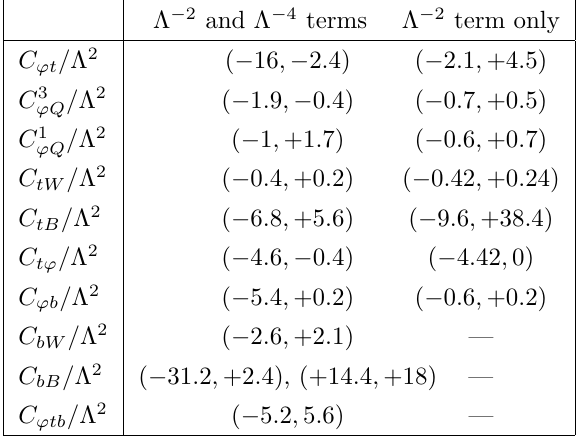
Table 2 . The 68% probability intervals on the dimension-six operator coe(cid:14)cients in units of TeV (cid:0) 2 . These results are obtained with a (cid:12)t to LHC and LEP/SLC data for two parameterizations of the dependence of the observables on dimension-six operator coe(cid:14)cients. The (cid:12)rst column lists the results from the (cid:12)t based on the nominal parameterization, which includes terms proportional to (cid:3) (cid:0) 2 and (cid:3) (cid:0) 4 terms. The second column is obtained with a (cid:12)t based on a parameterization